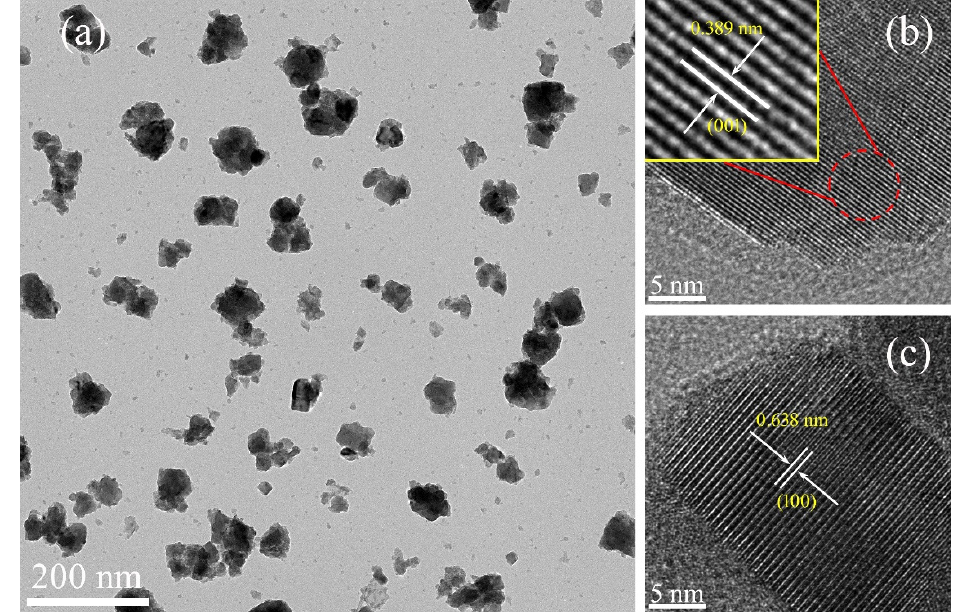
Figure 4. TEM image ( a ) and HRTEM images ( b and c ) of the Na x WO 3 nanoparticles with Na/W ratio of